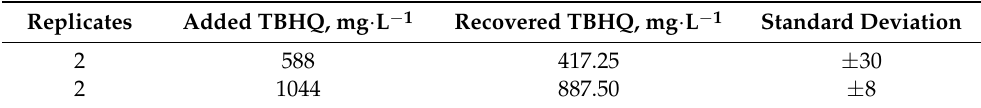
Table 4. TBHQ concentration in doped FOBL through emulsion medium (588 and 1044 mg · L − 1 ) through CV.